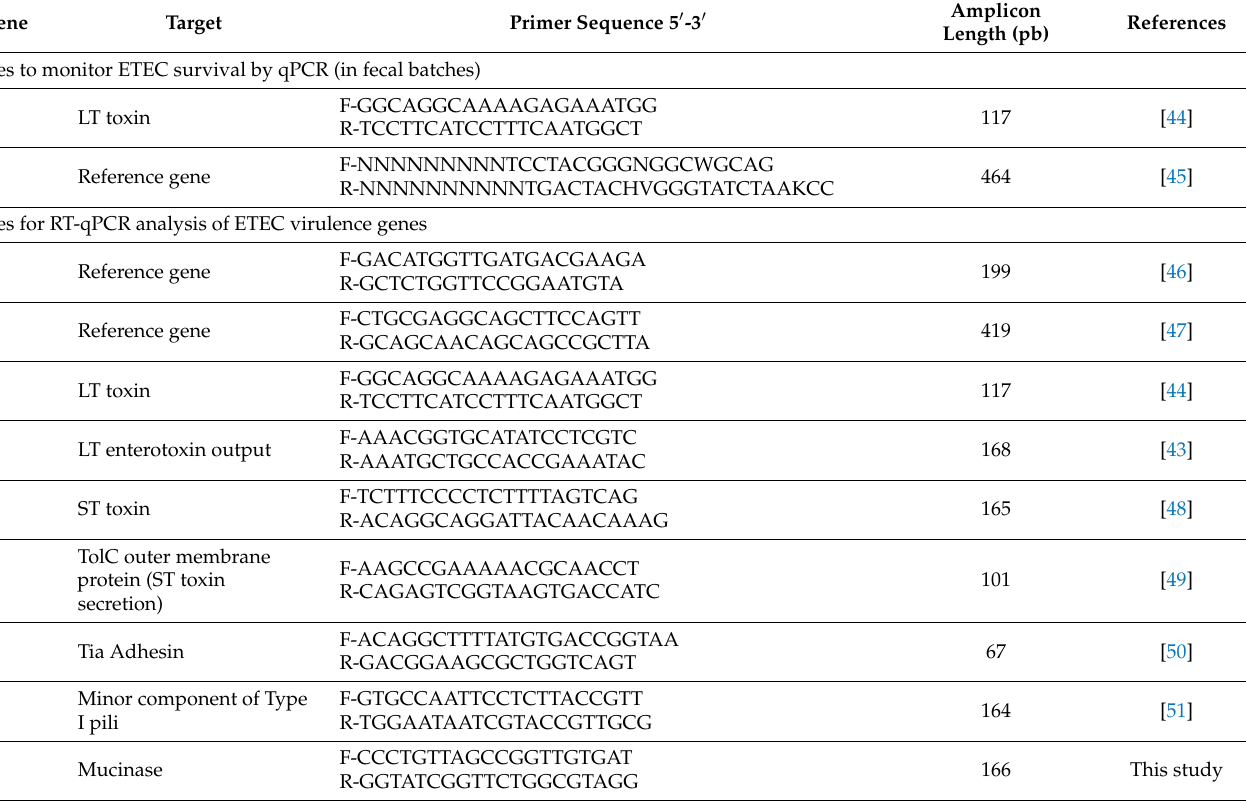
Table 2. Primers used in this